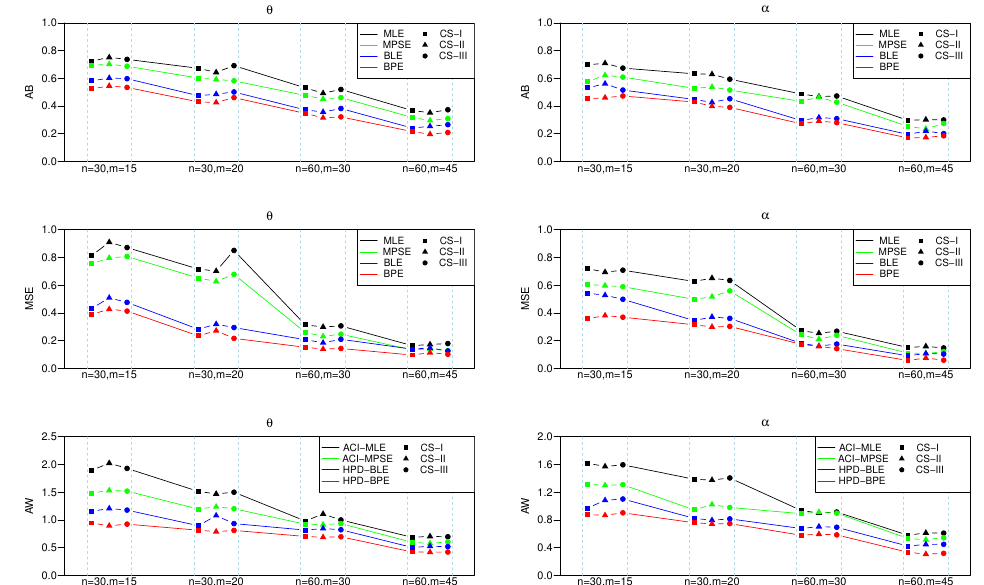
Figure 1. Plots of AB, MSE and AW for the model parameters at ( α , θ ) = ( 1.4,1.0 ) .